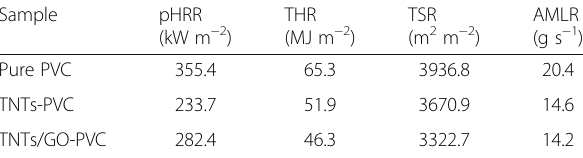
Table 3 Cone calorimetric data of pure PVC and its composites